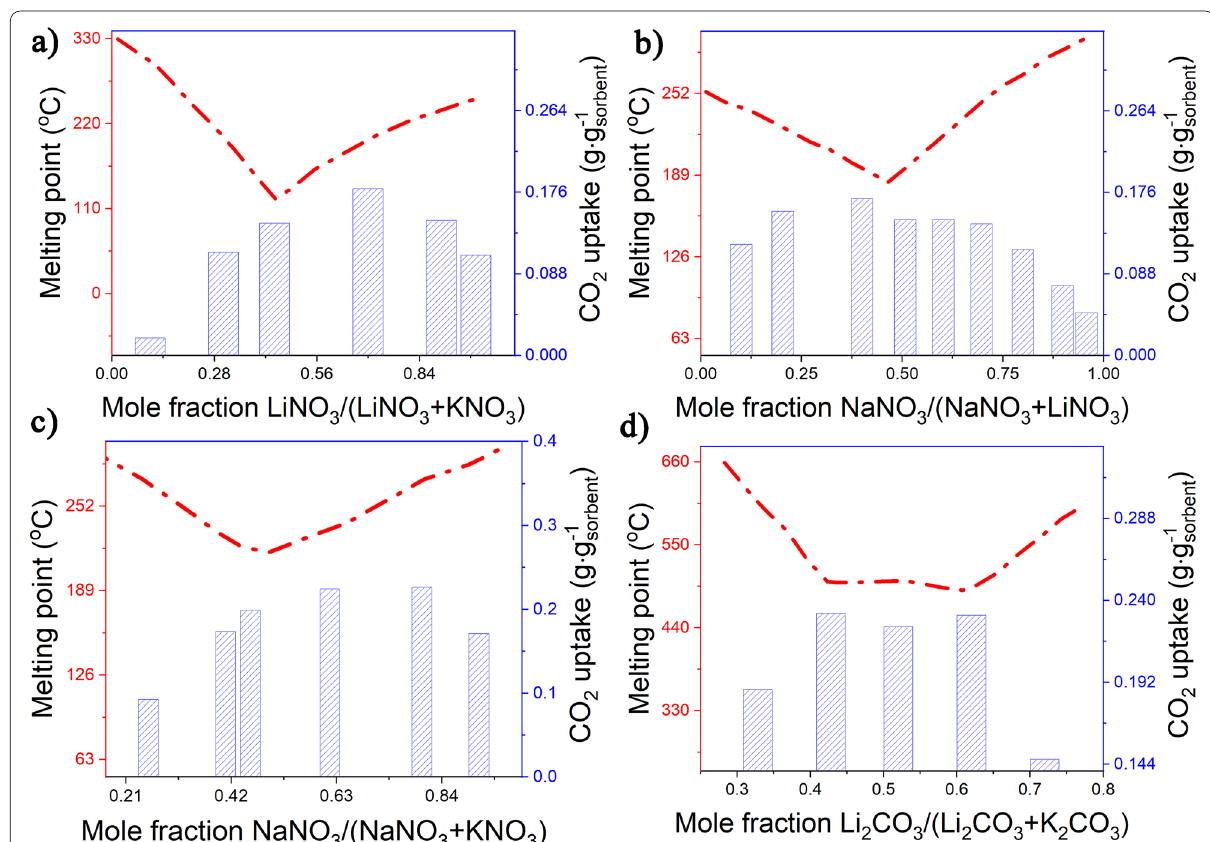
Fig. 14 CO 2 uptake performance of AEMOs promoted by 10 mol% binary molten salts as a function of the composition of the coating mixture (and hence their melting point): a (Na,K)NO 3 , b (Li,Na)NO 3 , c (Li,K)NO 3 for MgO and d (Li,K) 2 CO 3 for CaO [75,